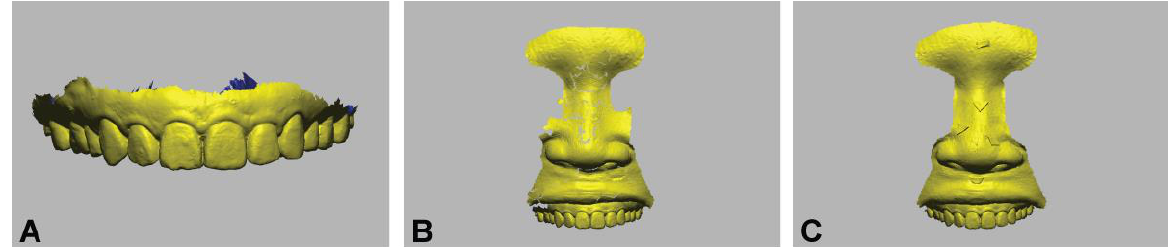
Figure 2. Dental image acquisition conducted with an intraoral optical scanner. ( A ) Intraoral scan; ( B ) intraoral and perioral scans obtained without an artificial marker; ( C ) intraoral and perioral scans obtained with artificial markers.